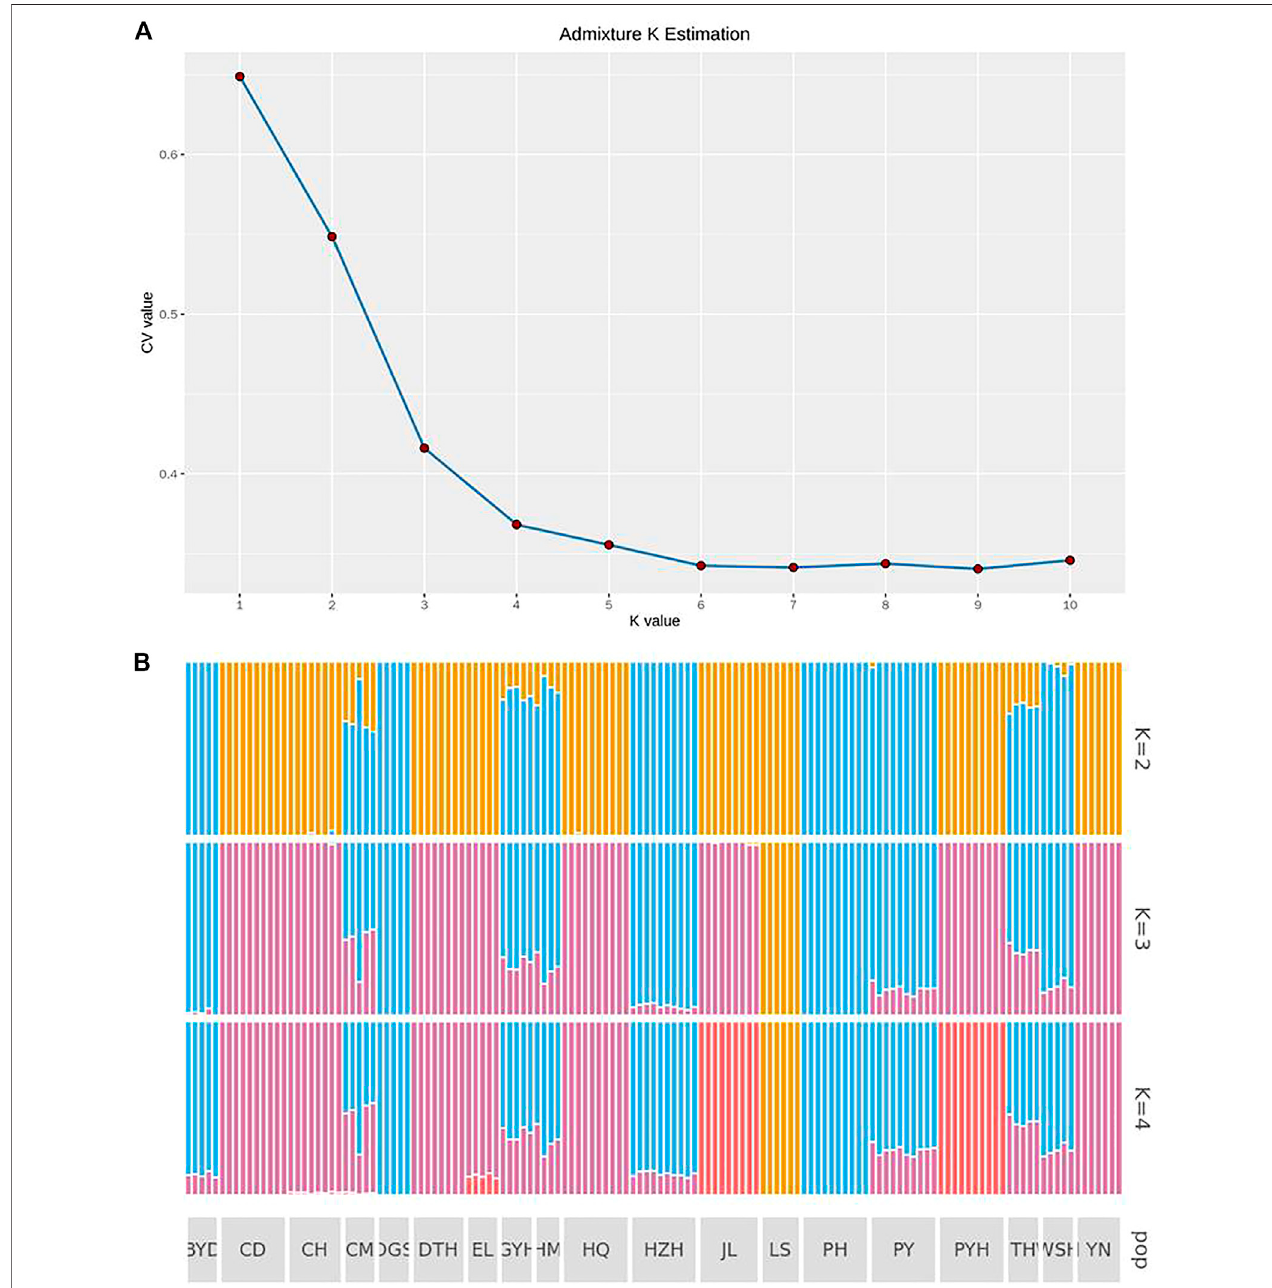
FIGURE 3 | Analysis of population genetic structure (A) when the ancestor number is assumed to be 2 – 4 and the possible K value (B) by using admixture K estimation. The abbreviations represent the sampling sites: BYD, Baiyangdian Lake; CD, Chengdu City; CH, Chaohu Lake; CM, Chongming Island; DGS, Dagushan; DTH,DongtingLake;EL,Elivillage;GYH,GaoyouLake;HM,HaimenCity;HQ,HuoqiuCounty;HZH,HongzeLake;JL,JiaolingCounty;LS,LingshuiCounty;PH,Pinghu City; PY, Puyang City; PYH, Poyang Lake; TH, Tai Lake; WSH, Weishan Lake; YN,